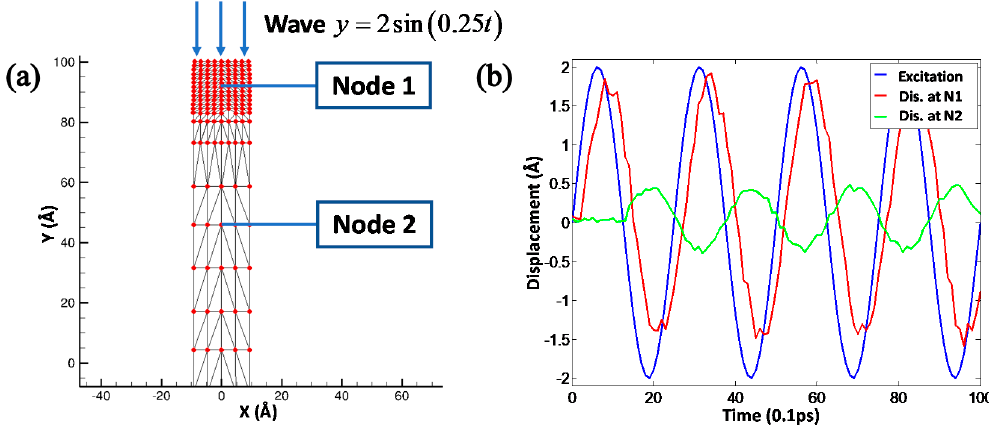
Figure 2. The validation of the QC method by 1-D wave propagation. ( a ) A sinusoidal actuation is imposed on the terminal of copper ribbon. ( b ) The displacement of nodes 1 and 2 with respect to the simulation time.